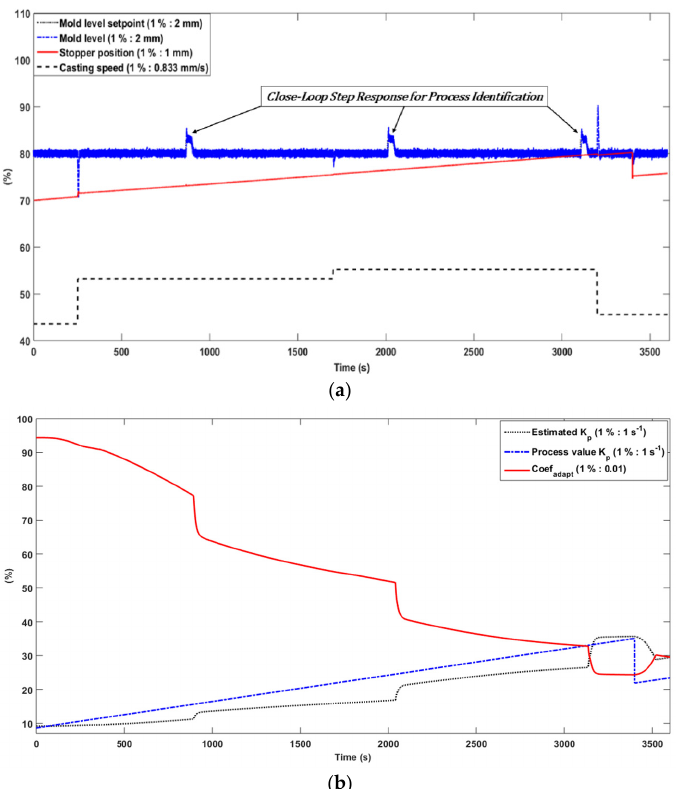
Figure 8. Simulation of adaptive mold level control for a cast with high SR clogging: ( a ) Mold level performance; ( b ) Diagnostic and compensation of process gain change by valve clogging.